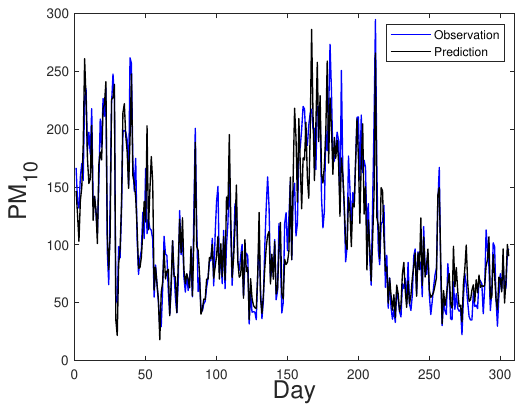
Figure 13. Plot of observed versus predicted PM 10 levels for Student-t PVCM (Lima data).